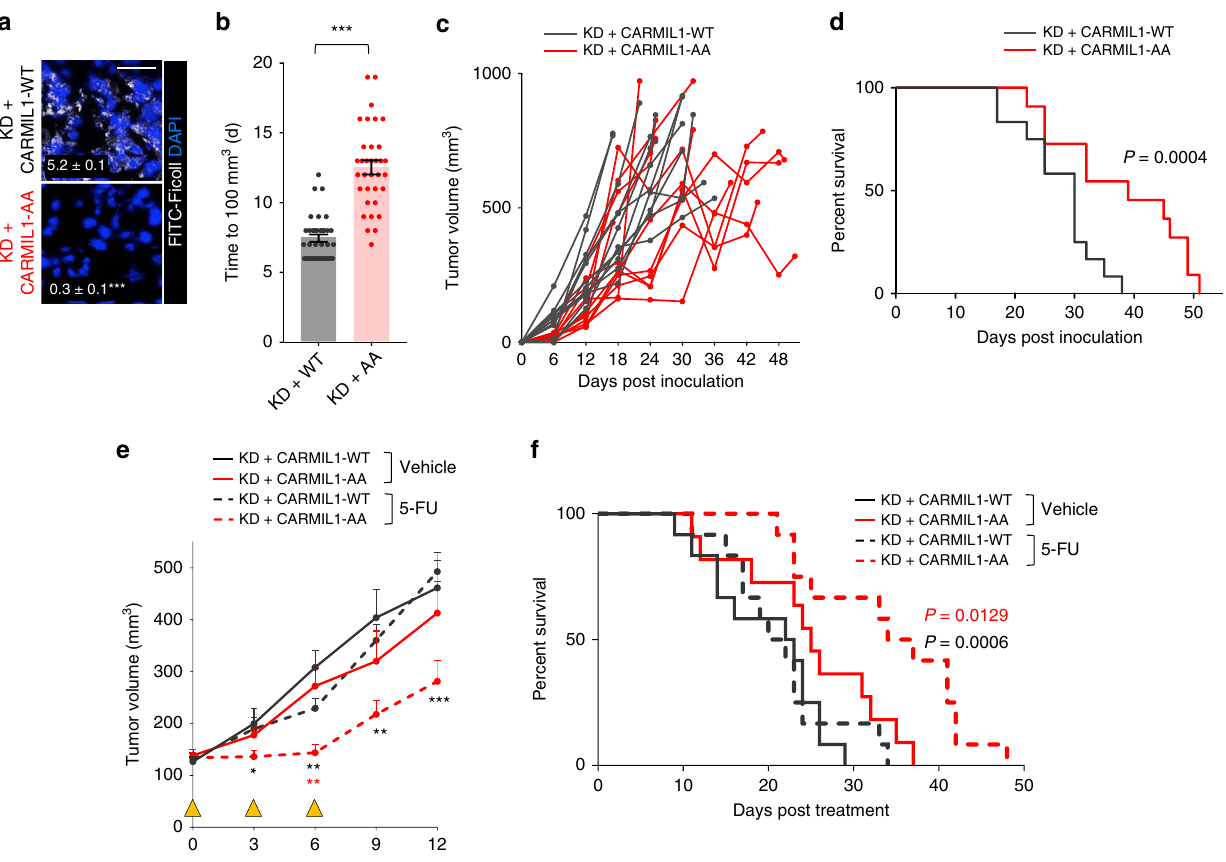
Fig. 7 Macropinocytosis promotes tumor growth and fuels resistance to 5-FU in vivo. a FITC-Ficoll uptake in orthotopic 4T1 tumors generated from CARMIL1-WT or CARMIL1 - AA cells. Ficoll fi eld-index was calculated from 10 fi elds from 3 (CARMIL1-WT) or 4 (CARMIL1-AA) tumor sections; Ficoll fi eld index ± SEM in white. Using an unpaired, two-tailed t test, *** P ≤ 0.001. Scale bar, 20 µ m. b Time to reach 100 mm 3 for tumors formed from CARMIL1-WT ( n = 26) or CARMIL1-AA cells ( n = 25); tumor volume was measured with calipers daily starting on day 6. Using an unpaired, two-tailed t test, ***, P ≤ 0.001, mean ± SEM. c Growth of the tumors in b . d Kaplan – Meier survival analysis in mice bearing CARMIL1-WT ( n = 12) or CARMIL1-AA ( n = 11)